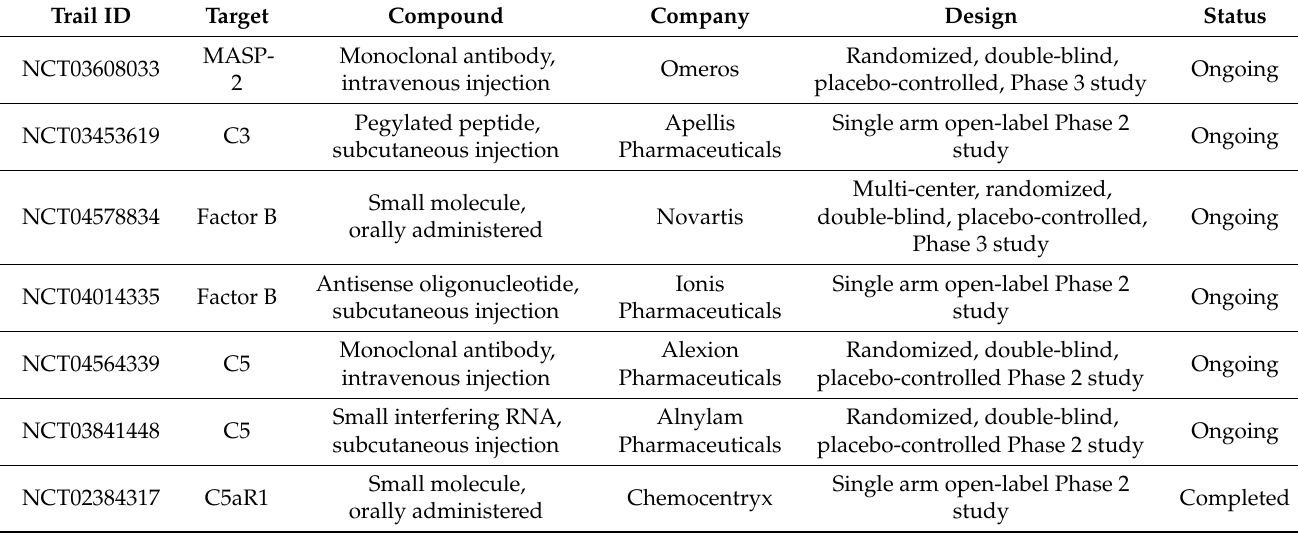
Table 2. Clinical trials with complement inhibitors in IgA